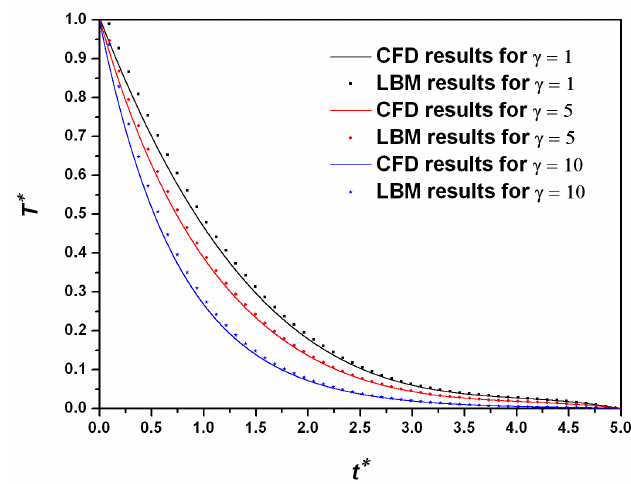
Figure 3. Comparisons of the average temperatures of liquid droplet between the LB method and the level set approach. (The horizontal coordinate is dimensionless temperature )/( TTTT   and the ordinate coordinate is dimensionless time 2 / Rtt ,,, iniginilal